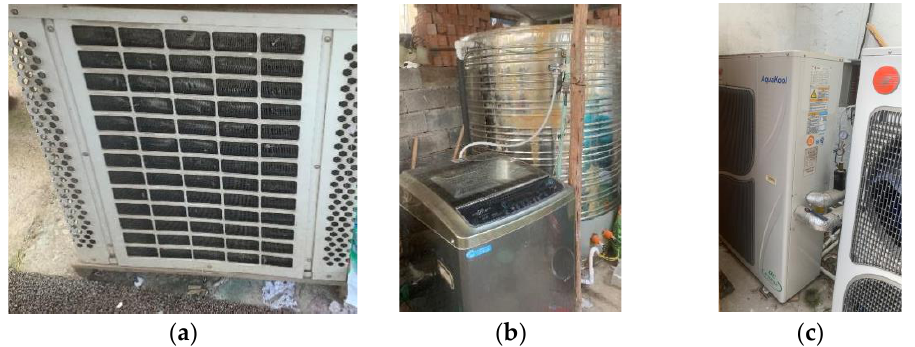
Figure 3. Photos of home hotel energy-using equipment: ( a ) air source heat pump as a water heater; ( b ) electric water heater; ( c ) air source heat pump for air conditioning.